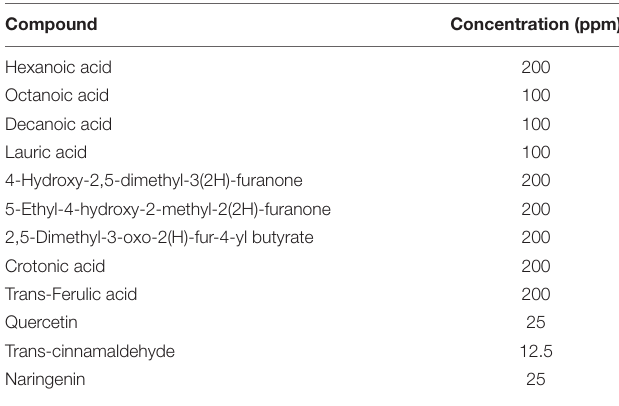
TABLE 1 | Concentration of each compound used in the screening of quorum sensing inhibitory